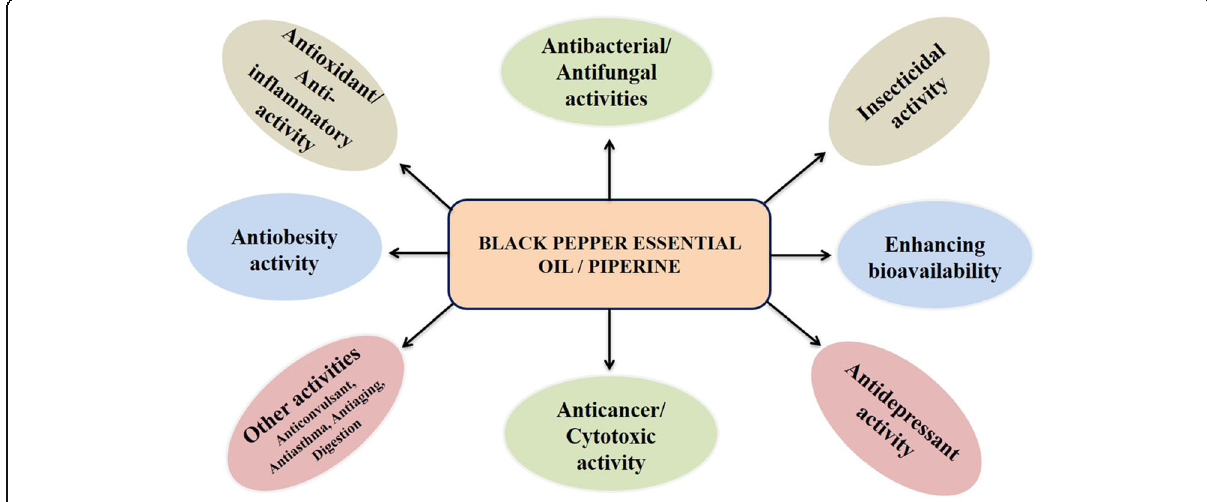
Fig. 3 Diagrammatic representation of black pepper essential oil and piperine potential biological